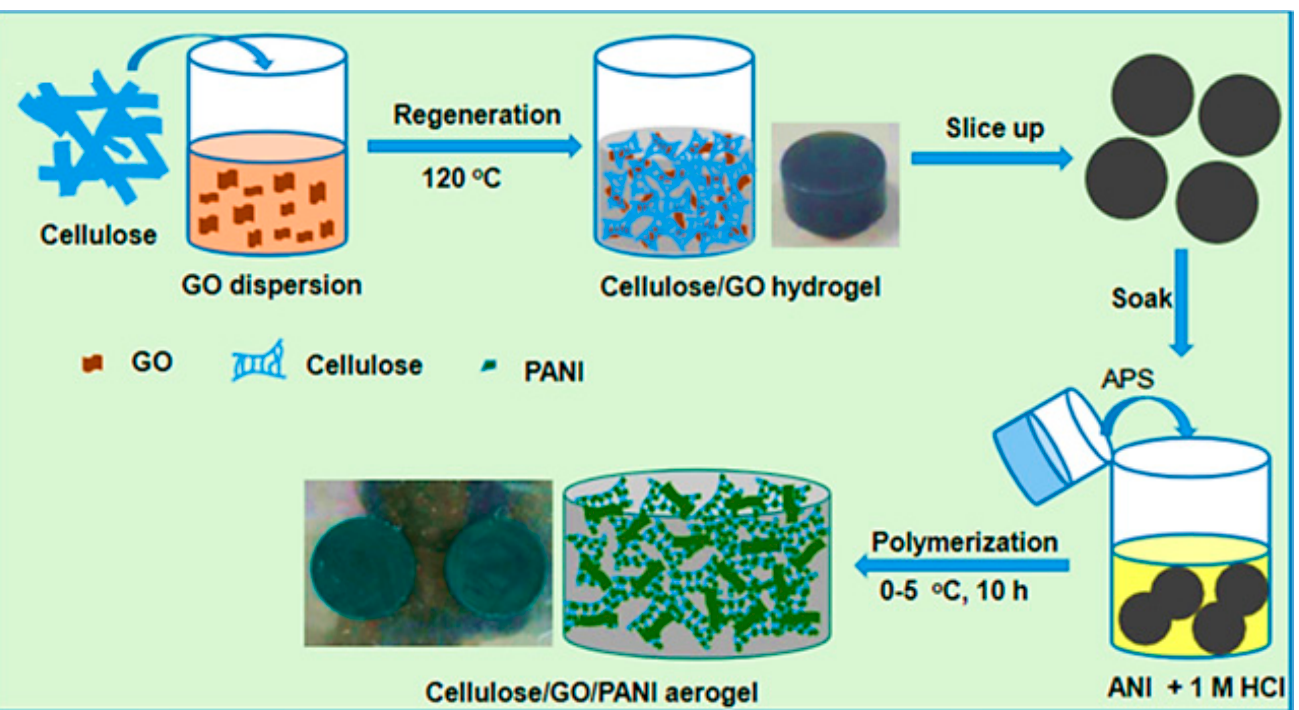
Figure 13. Synthetic pathway of the cellulose/graphene oxide/polyaniline [128]. GO = graphene oxide; PANI = polyaniline; ANI = aniline. Reproduced with permission from MDPI.